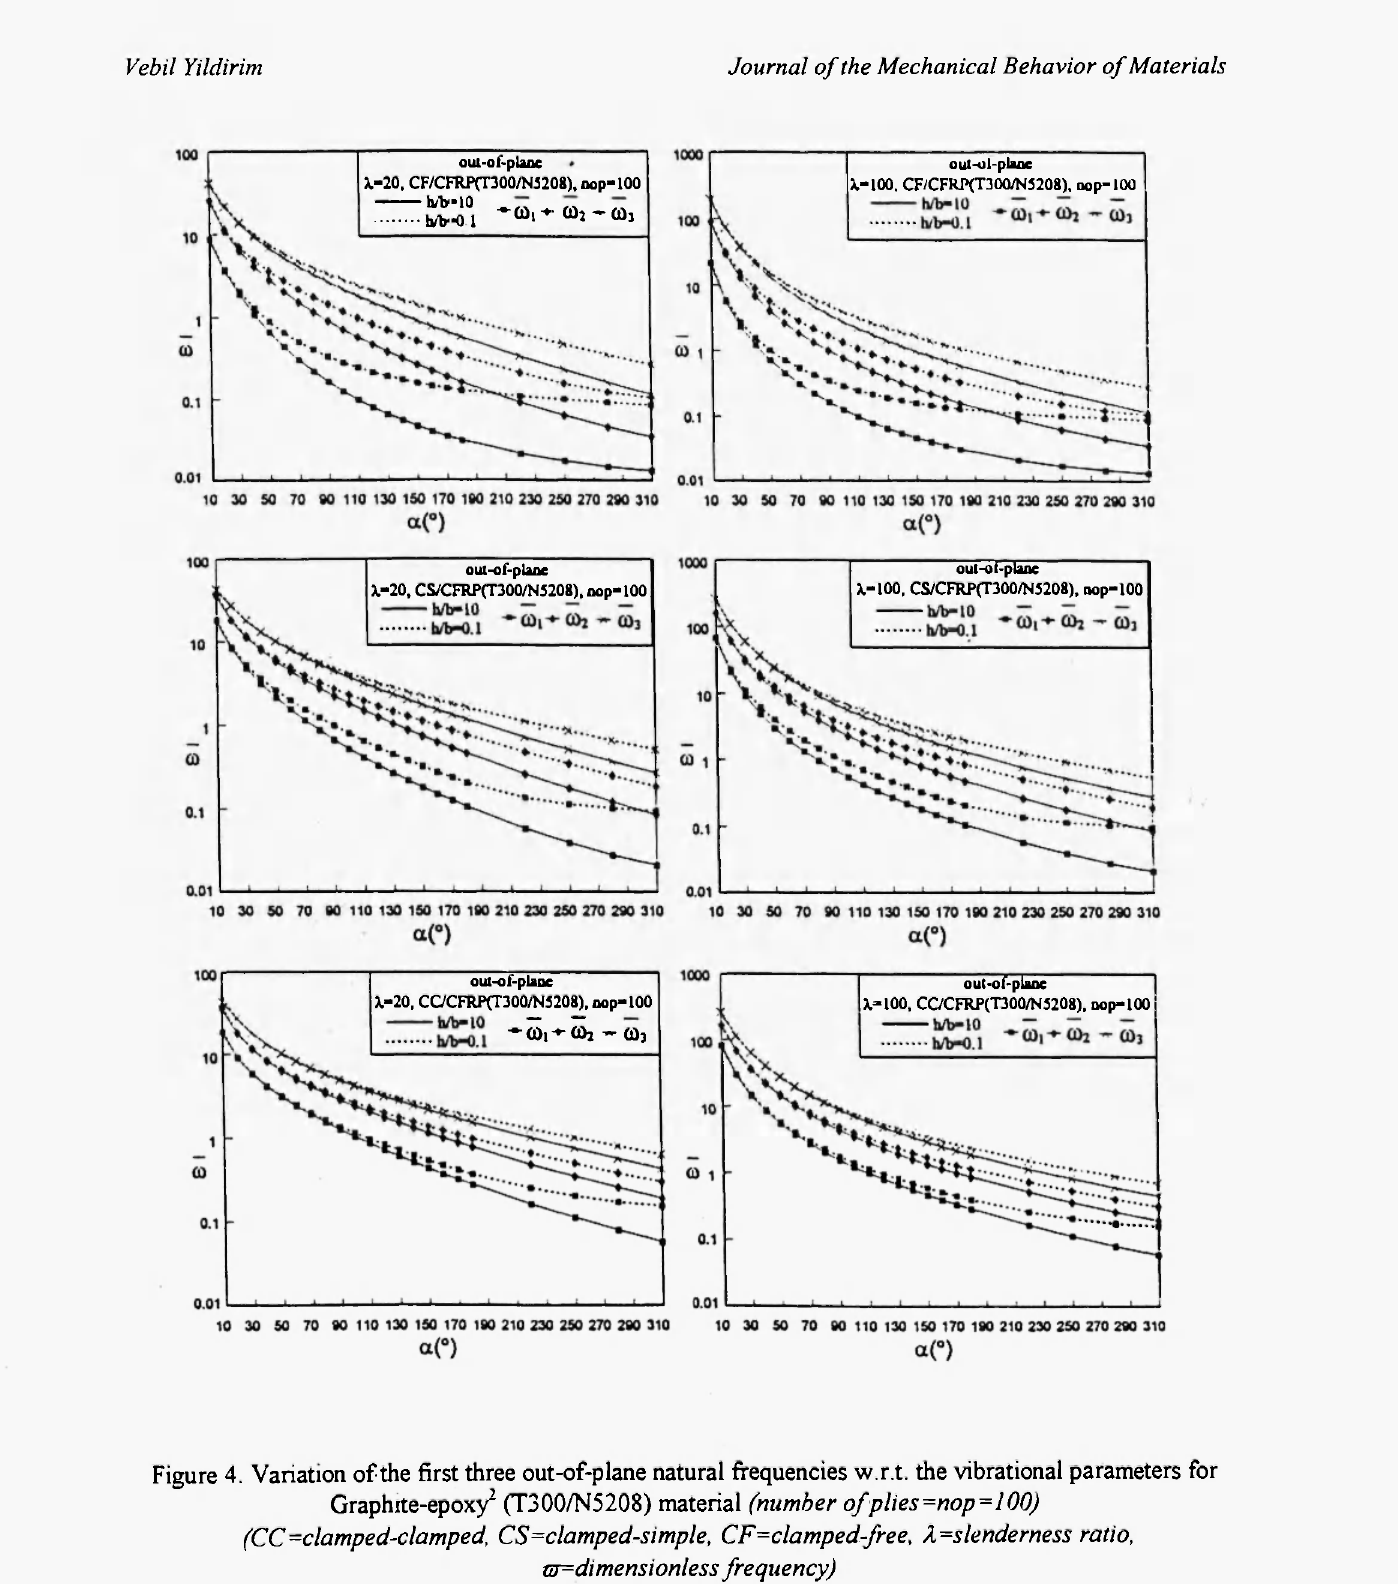
Figure 4. Variation of the first three out-of-plane natural frequencies w.r.t. the vibrational parameters for Graphite-epoxy 2 (T300/N5208) material (number of